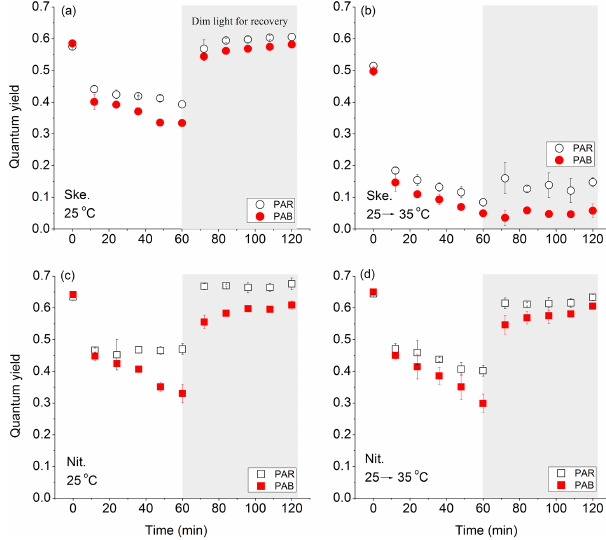
Figure 3. The quantum yields of 25 ◦ C grown Skeletonema sp. and Nitzschia sp. under PAR or PAB for 1h exposure and subsequent recovery under dim light (gray area) for 1h, which were incubated and measured at 25 ◦ C ( a Skeletonema sp., c Nitzschia sp.) or 35 ◦ C ( b Skeletonema sp., d Nitzschia sp.). Vertical lines represent SD, n = 3.